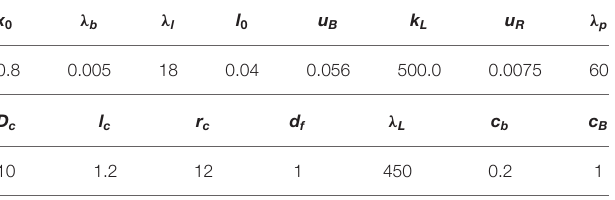
On the top, the values for the membrane evolution equation (equation for u ), and on the bottom, the additional parameters needed for the signal equation and the coupling between the two